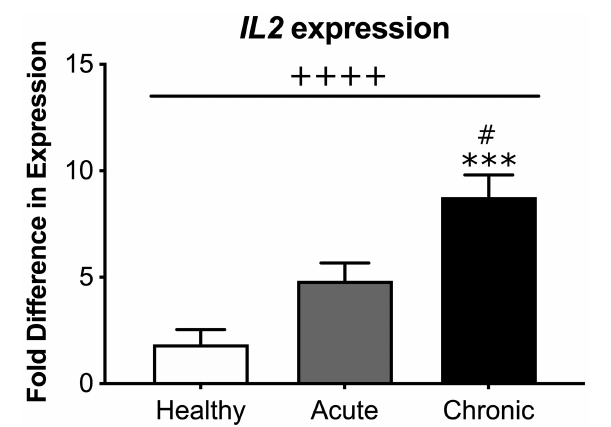
FIGURE 5 | Systemic interleukin 2 ( IL2) mRNA expression. There was an overall effect of group on IL2 expression measured from blood samples of participants. cLBP participants had significantly greater fold difference in IL2 expression compared to aLBP participants and healthy controls. + + ++ p <